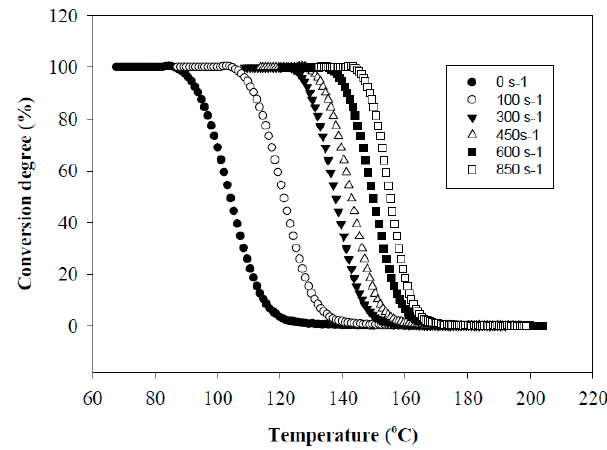
Figure 1. Dependencies of conversion degree of polyhydroxyalkanoate (PHA) during cooling with simultaneous shearing with various shearing rates. The conversion of melt into the crystalline phase was followed by recording the intensity of transmitted depolarized light.